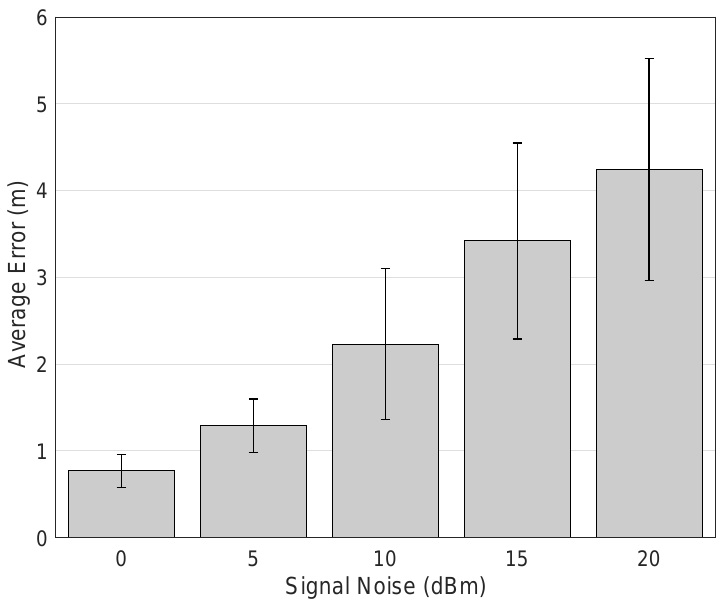
Figure 7. Effect of noise